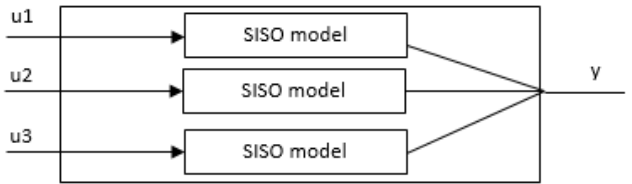
Figure 1. MISO model as a set of SISO models.